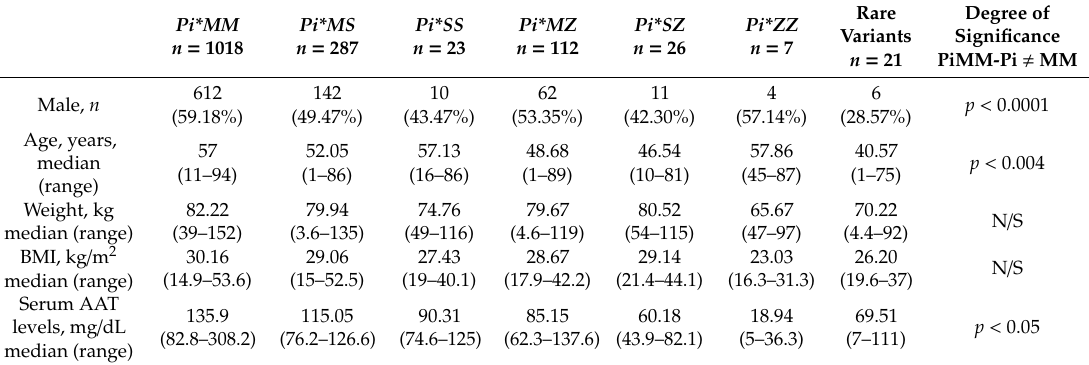
Table 1. Baseline characteristics of study patients. N / S: not significant. BMI: body mass index.